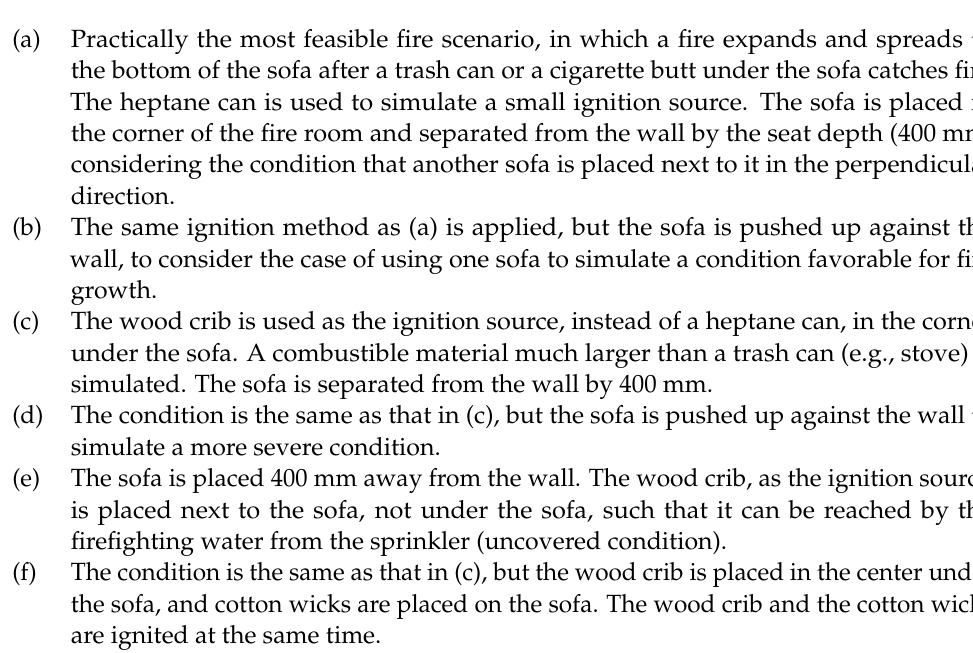
Figure 7. Application of various ignition sources to the construction of the fire source of the fuel package.